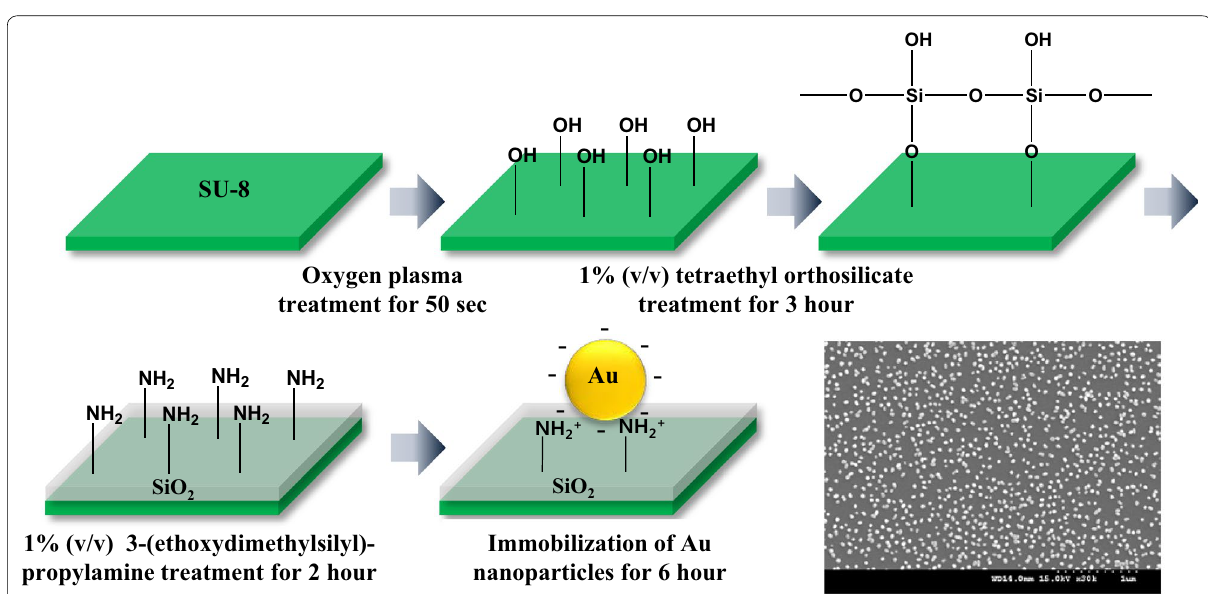
Fig. 3 The immobilization process of Au nanoparticles on OWG and the FE‑SEM image of attached nanoparticles on